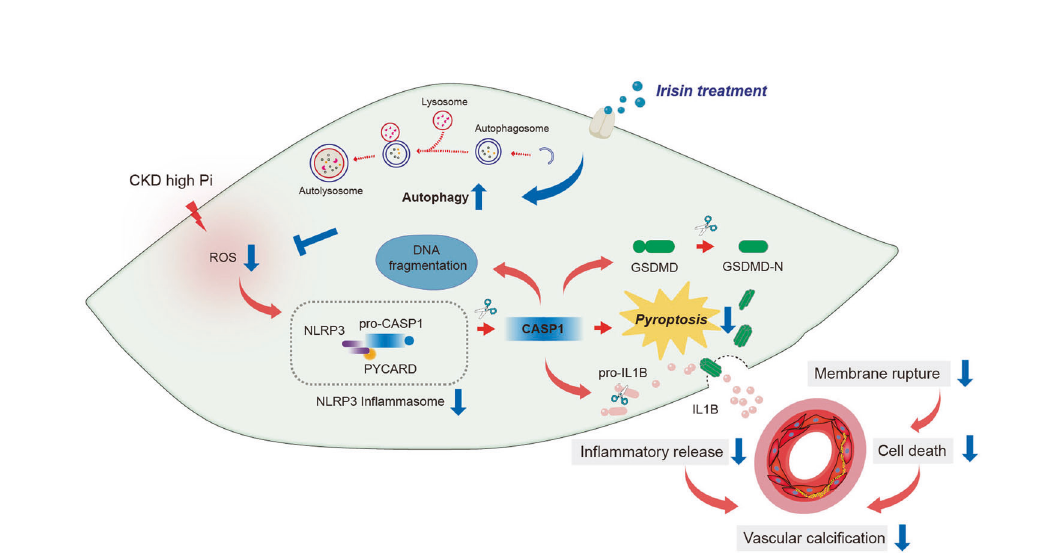
Fig. 8 A graphic illustration of the protective role of Irisin in CKD-associated VC. High phosphate (Pi) induces the production of ROS, which activates NLRP3 in fl ammasome, leads to the activation of CASP1-dependent pyroptotic cell death, and release of in fl ammatory factors in VSMCs, and ultimately promotes the formation of VC in CKD ( Red arrows ). Irisin induces autophagy and reduces ROS production. These effects lead to inhibition of NLRP3-mediated pyroptotic cell death, proin fl ammatory response, and calcium deposition in VSMCs, and ameliorate the progression of VC in CKD ( Blue arrows